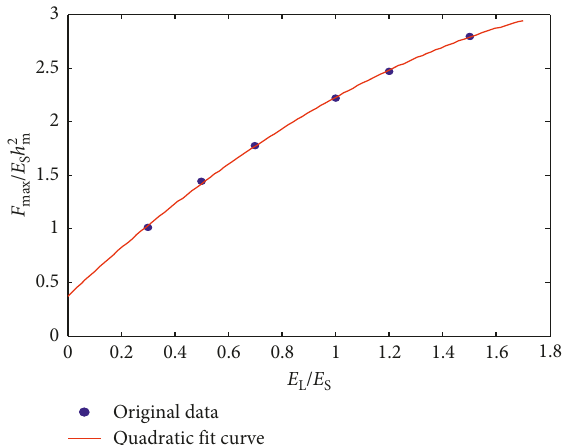
Figure 6: Quadratic curve fitting of F